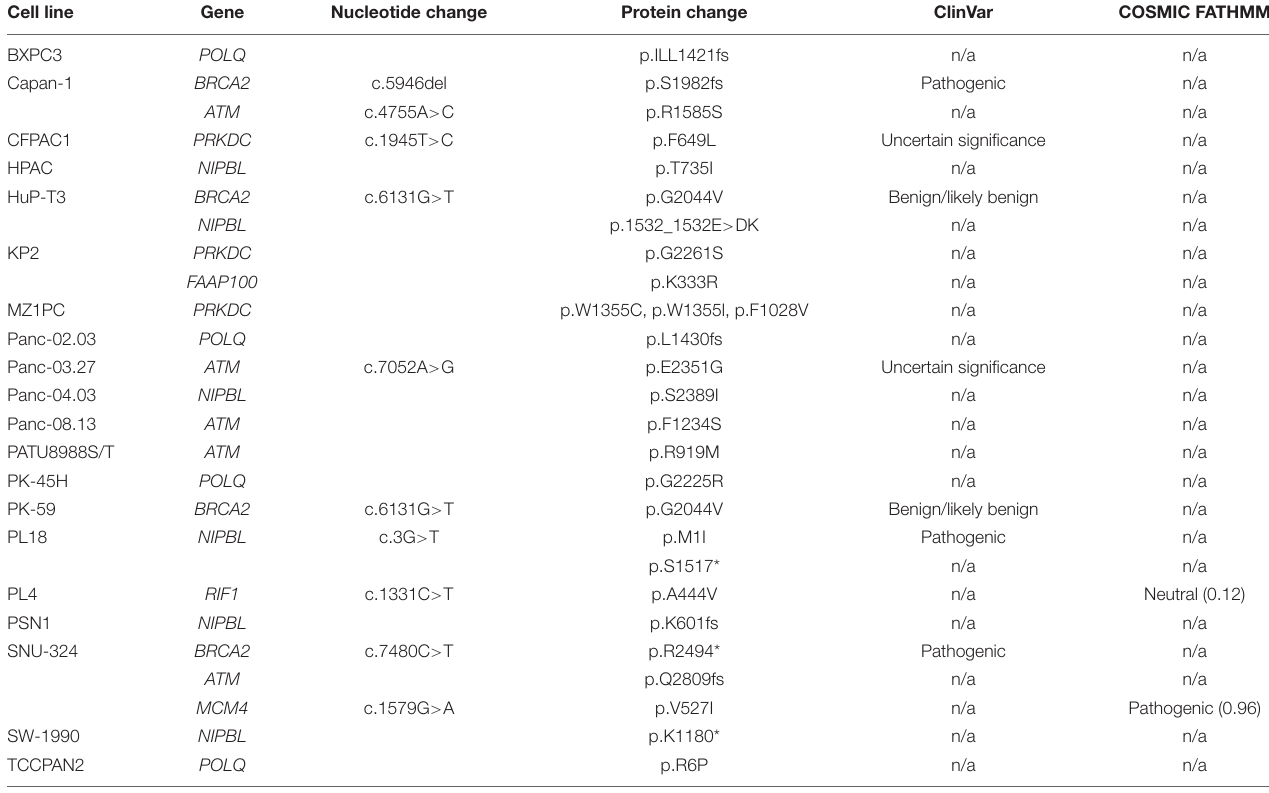
TABLE 2 | Mutation status of DDR genes in cell